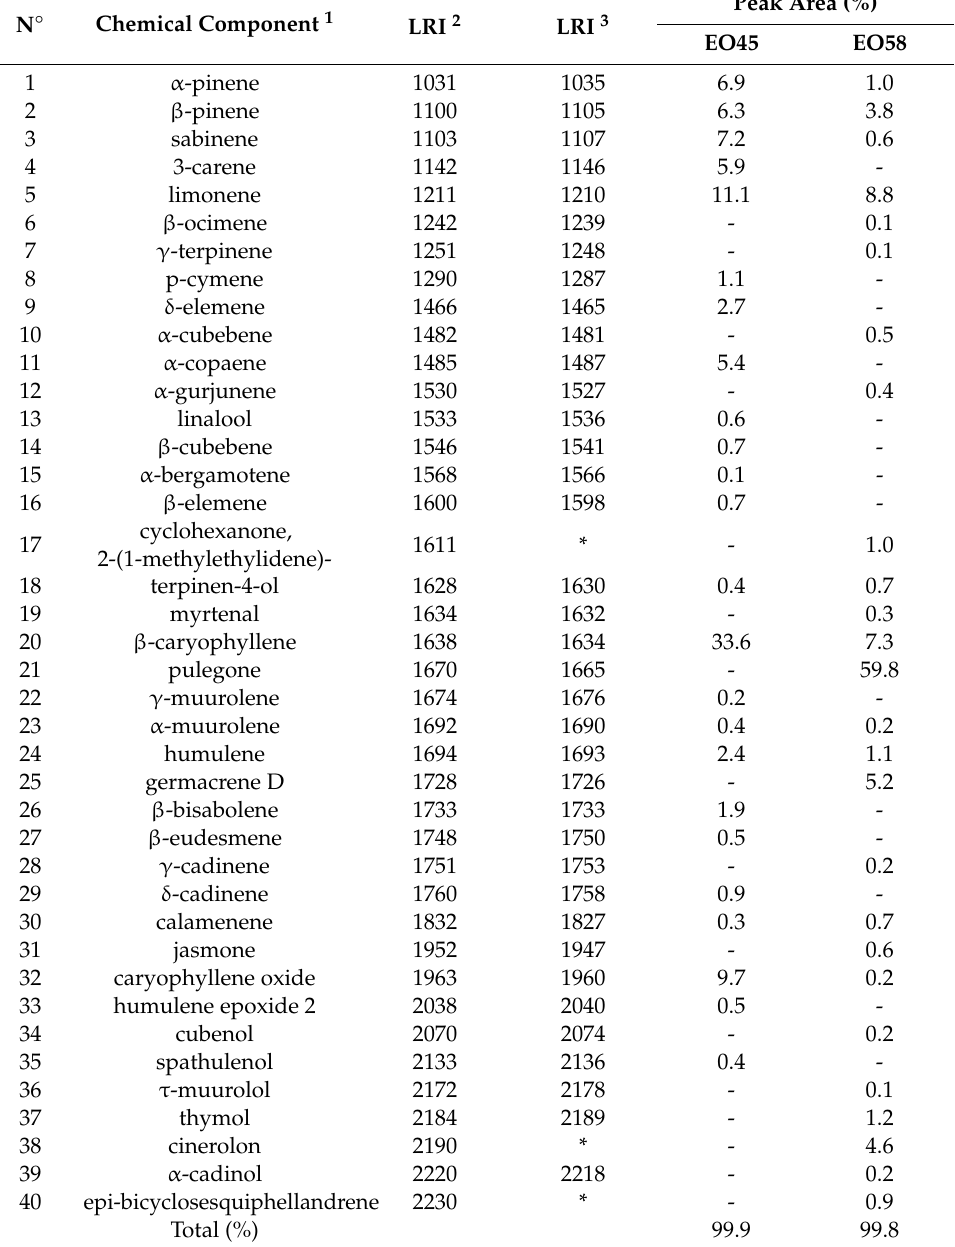
Table 1. Chemical composition (%) of EO45 and EO58 obtained by